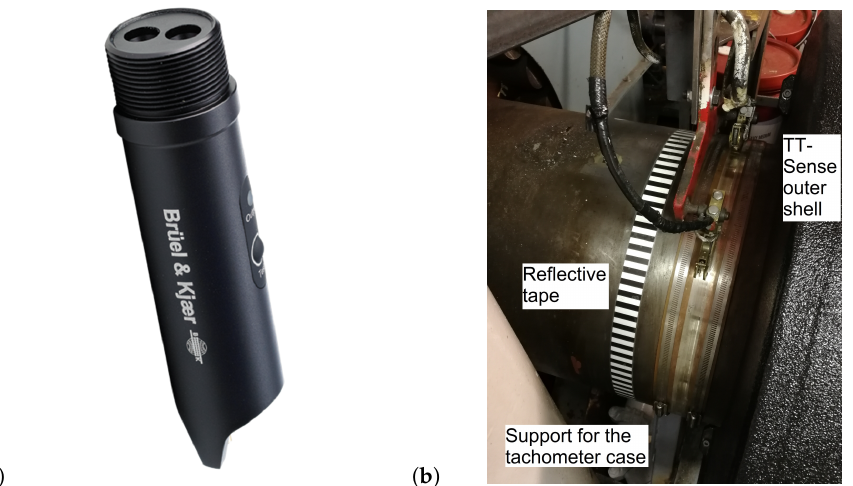
Figure 4. Brüel & Kjær Type 2981 laser tachometer ( a ); accommodation on the Starboard shaft ( b